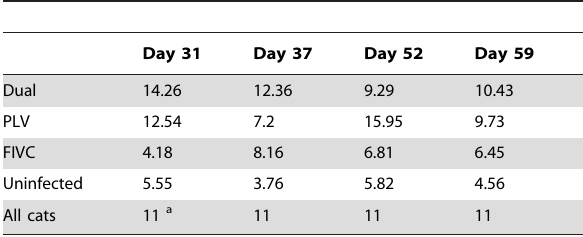
Table 6. Total variances within infection status groups on different